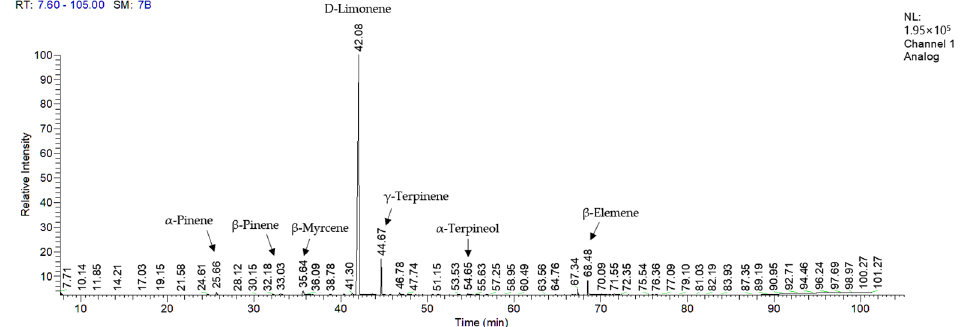
Figure 1. Total ion chromatogram of essential oils from Citrus reticulata using GC–MS.